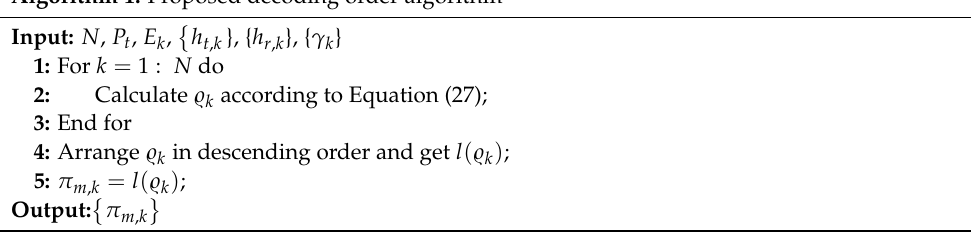
Algorithm 1. Proposed decoding order